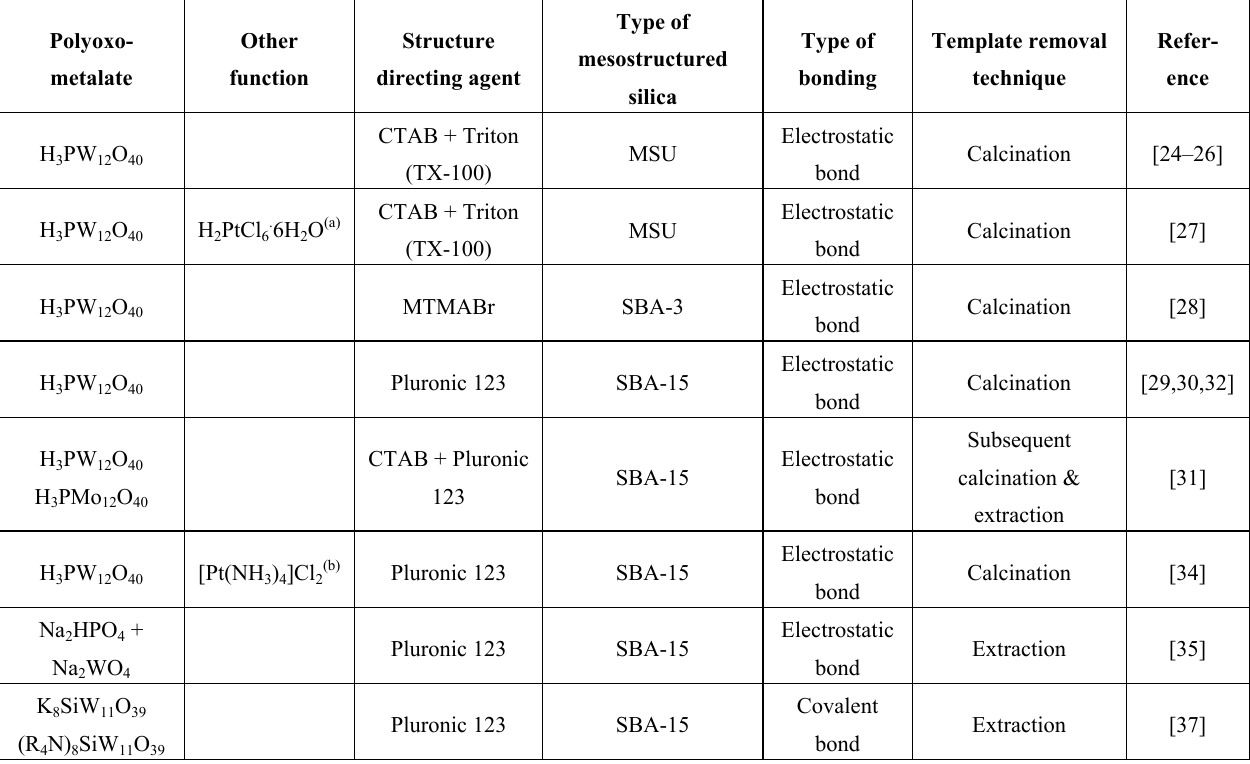
Table 1. Major synthetic routes to mesostructured silica based materials containing entrapped